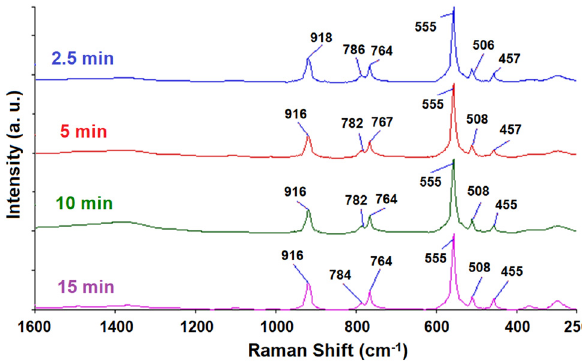
Figure 1: Raman spectra of the santite synthesized at KC – H set at 60°C reaction temperature.